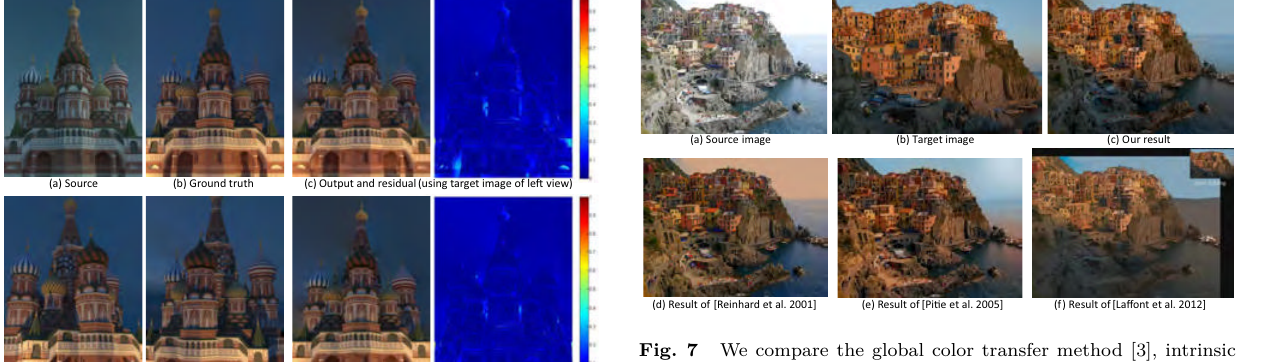
Fig. 7 We compare the global color transfer method [3], intrinsic image decomposition [14], and our lighting transfer method. While the results of other methods have either wrong color tone (c) or artifacts (d), our result has appropriate lighting similar to the target image